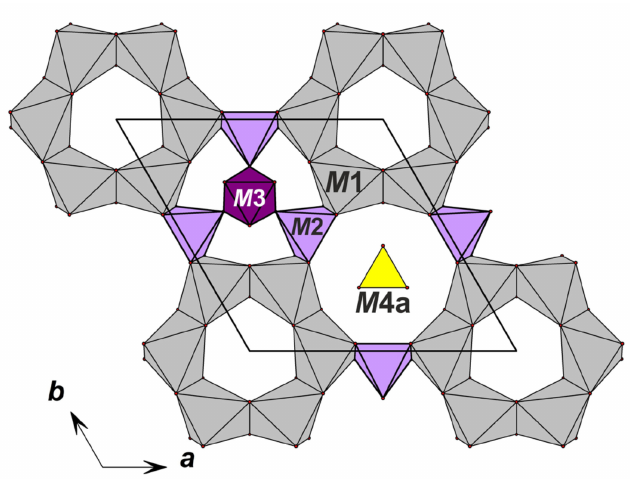
Figure 5. Heteropolyhedral layer involving rings of CaO 6 octahedra in the structure of odikhinchaite.